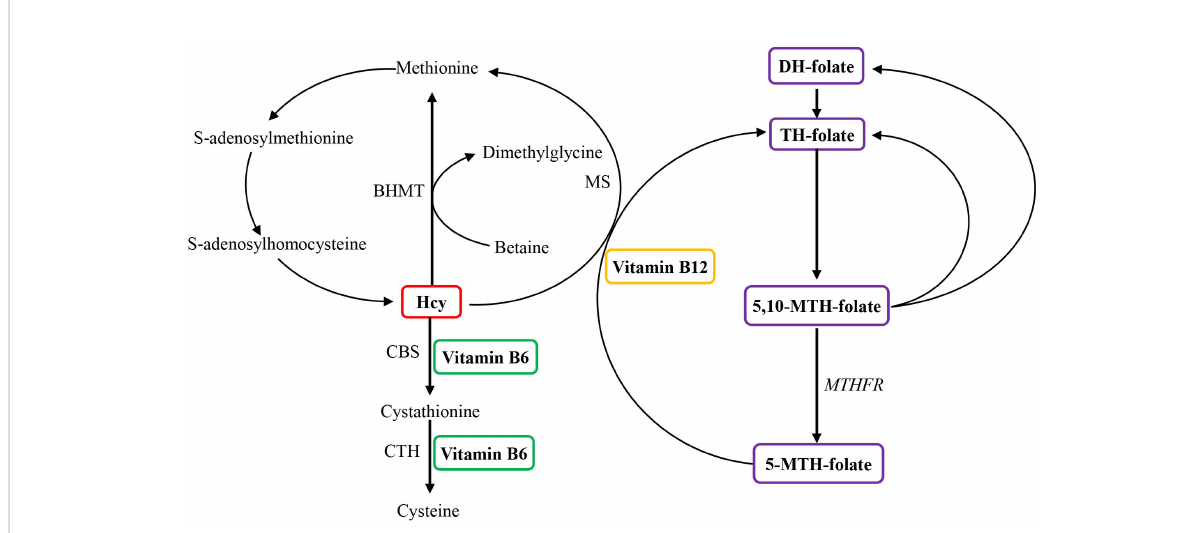
FIGURE 1 Overview of the role of vitamin B6, vitamin B12, and folate in homocysteine metabolism. Homocysteine is reconverted to methionine by acquiring a methyl group from 5-methyltetrahydrofolate, the positive form of betaine, or folate in the remethylation pathway. Irreversible removal of homocysteine happens across the transsulfuration pathway in which homocysteine condenses with serine to form cystathionine. BHMT, betaine homocysteine methyltransferase; CBS, cystathionine- b -synthase; CTH, cystathionine-gamma-ligase; DH, dihydo; Hcy, homocysteine; MS, methionine synthase (encoded by the MTR gene); MTH, methylenetetrahydrofolate; MTHFR, methylenetetrahydrofolate reductase; TH, tetrahydro.